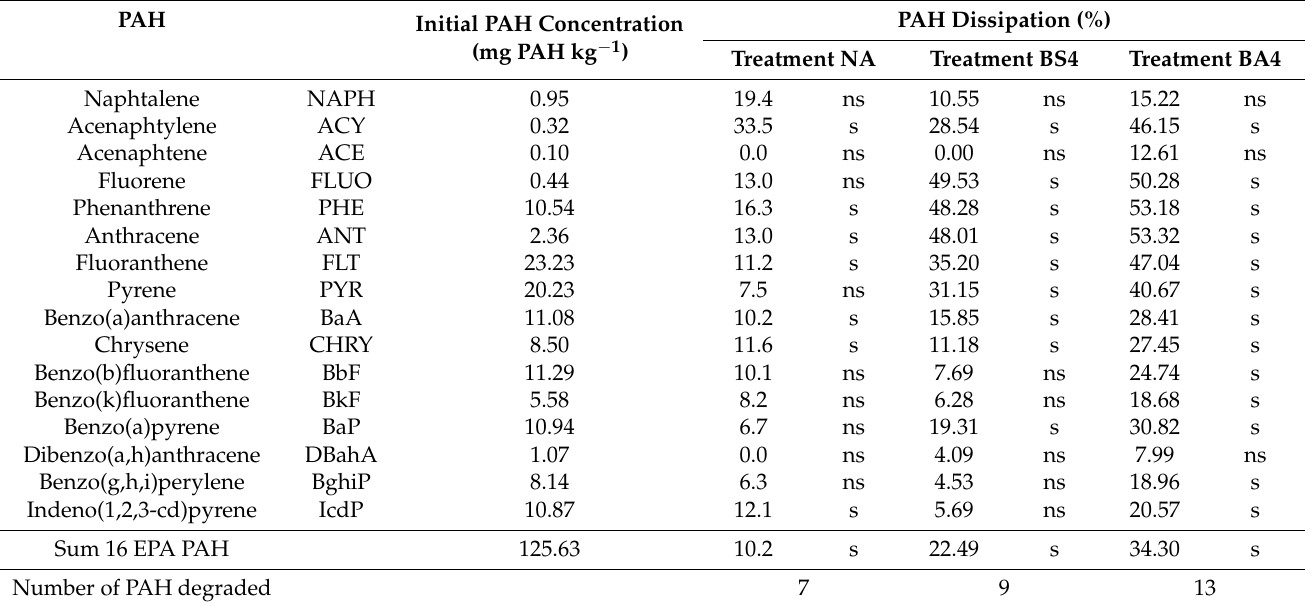
Table 2. Concentration of PAH in initial soil and PAH dissipation in soil microcosms after 8 months of incubation (mean value of quadruplicates). Treatments are identified in Table